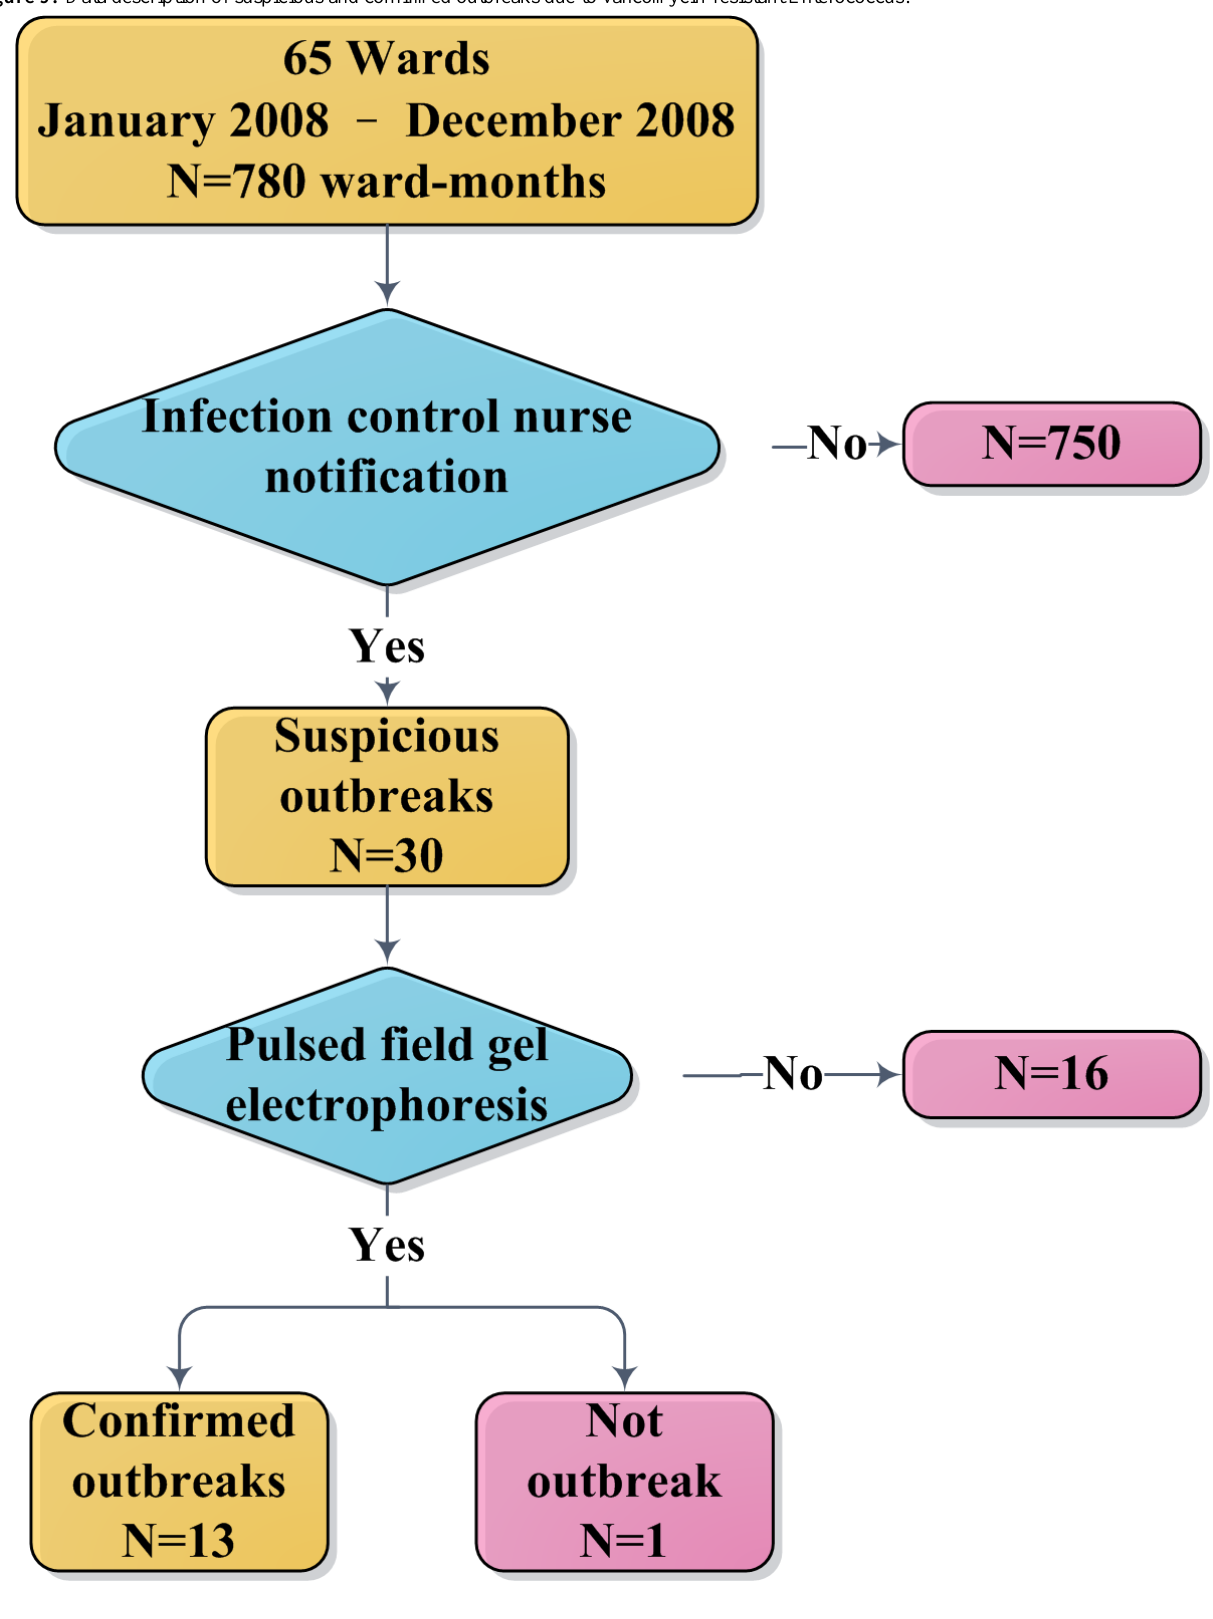
Figure 9. Data description of suspicious and confirmed outbreaks due to vancomycin-resistant